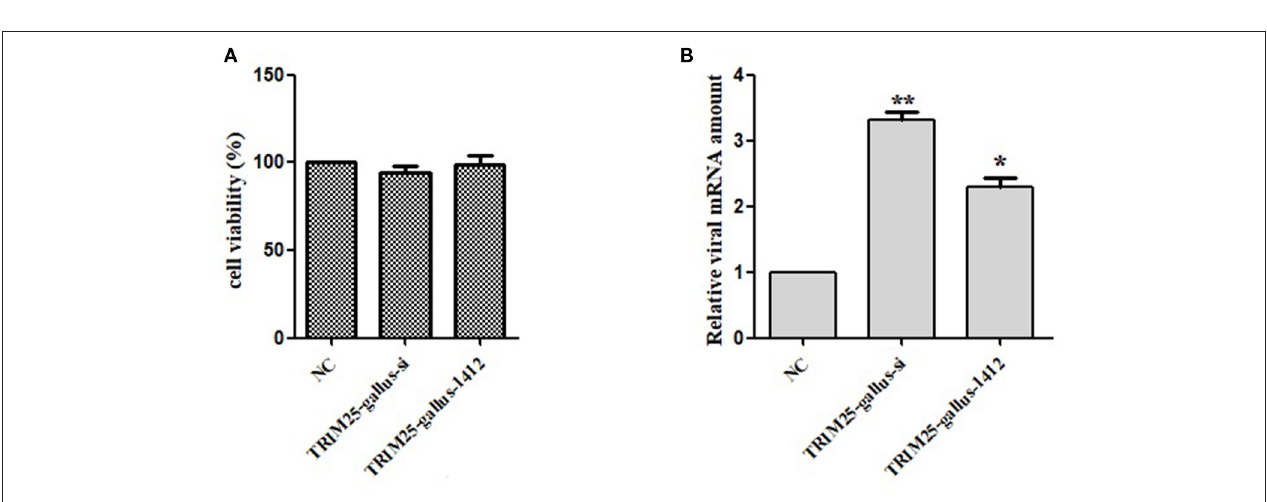
FIGURE 5 | Knockdown of TRIM25 by siRNA increases duck Tembusu virus (DTMUV) infection. (A) TRIM25 knockdown did not cause cell toxicity. (B) DTMUV mRNA expressioninTRIM25-silenced (TRIM25-gallus-si and TRIM25-gallus-1412) duck embryo fibroblasts and control cells the relative amount of DTMUV mRNA was